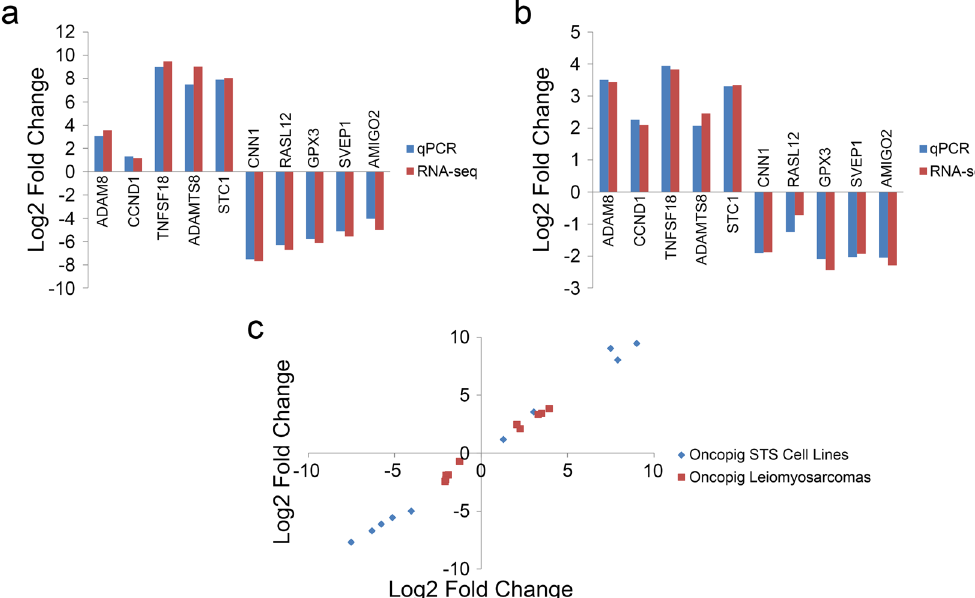
Figure 6. Independent validation confirms RNA-seq results. Log2 fold changes assessed using PCR and RNA- seq for 5 genes displaying elevated and reduced expression in the ( a ) Oncopig STS cell lines relative to controls and ( b ) leiomyosarcomas relative to controls. ( c ) Log2 fold changes assessed using qPCR and RNA-seq were highly correlated (Spearman’s Rho 0.992, p = 2.2 × 10 − 16